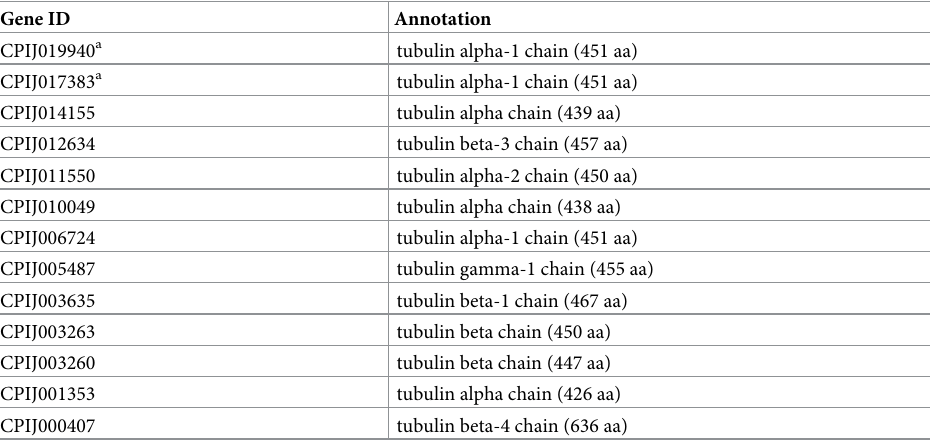
Table 5. Tubulin isoforms detected in the Culex sperm